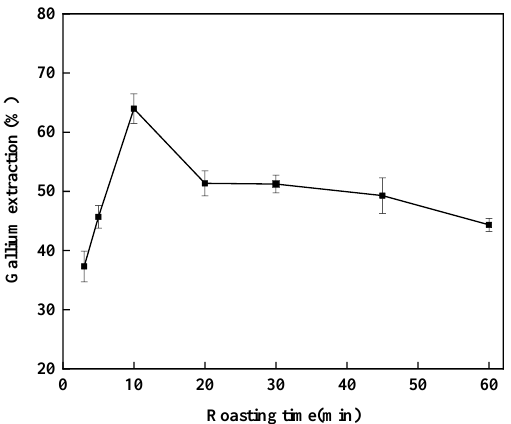
Figure 6. Influence of roasting time on gallium extraction (the NaF-CFA mass ratio of 1:1, roasting temperature of 800 °C, leaching temperature of 120 °C, leaching time of 2 h, and HNO 3 concentration of 2 mol/L).